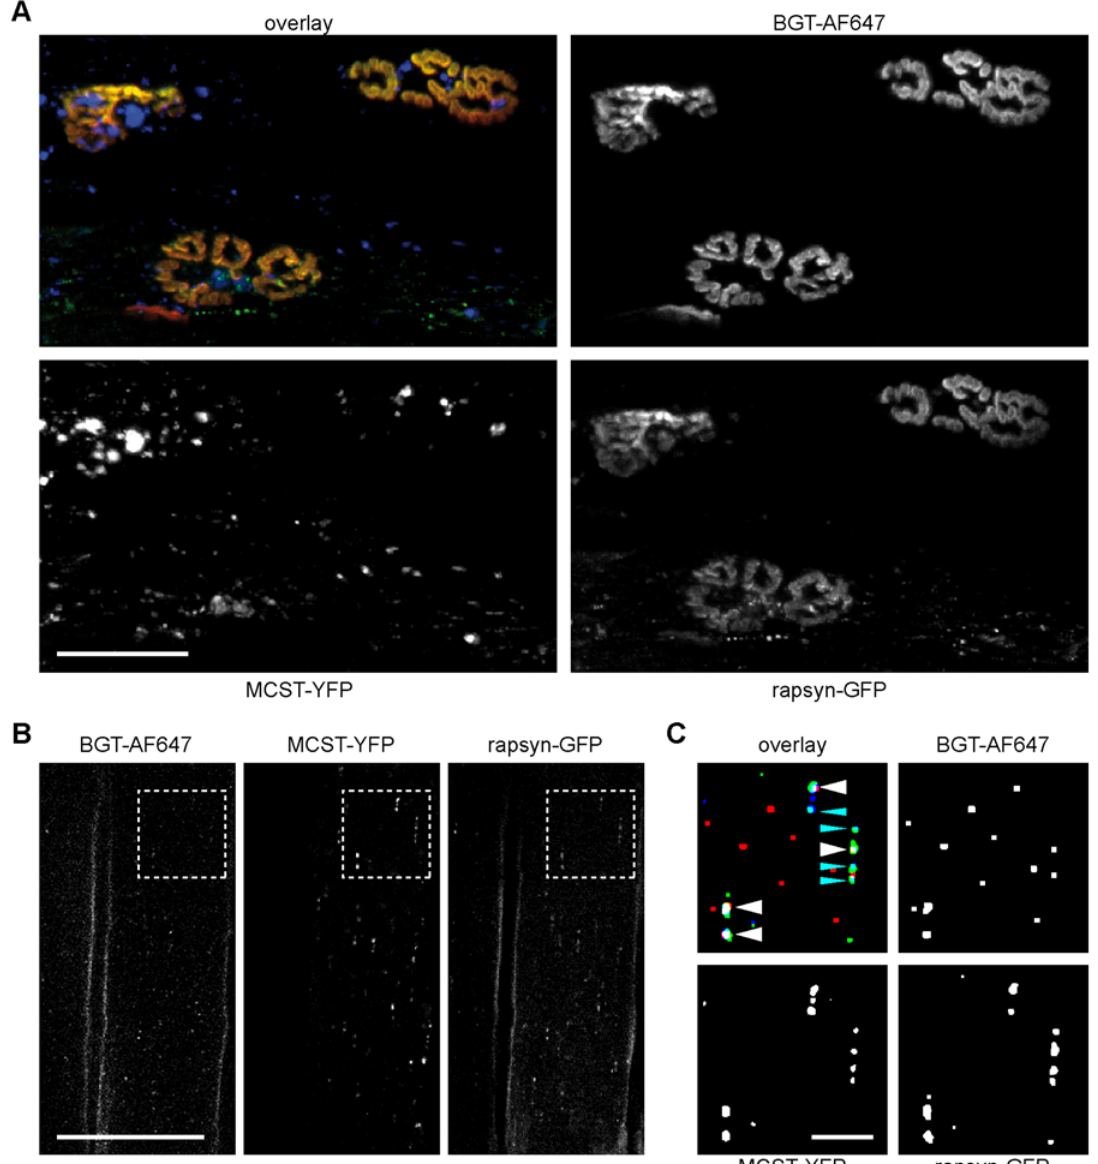
Figure 4. Myosin Va tail is enriched in punctate structures in the postsynaptic region of NMJs and co-localises with AChRs and rapsyn-GFP. TA muscles of adult wildtype mice were co-transfected with rapsyn-GFP and MCST-YFP. Ten days later, transfected muscles were locally injected with BGT-AF647 and then imaged with in vivo confocal microscopy. Overlay images, BGT-AF647 (red), rapsyn-GFP (green), MCST-YFP (blue). A: Maximum z-projection of 42 optical slices taken at 2 m m interslice distance encompassing the entire extension of shown NMJs in depth. Scale bar, 50 m m. B: Single layer through the center of a fibre. Scale bar, 50 m m. C: Binarised blow-up of the boxed region in (B). Overlay, punctate structures triple positive for BGT-AF647, rapsyn-GFP and MCST-YFP, white arrowheads; double positive for rapsyn-GFP and MCST-YFP, blue arrowheads. Scale bar, 10 m m.